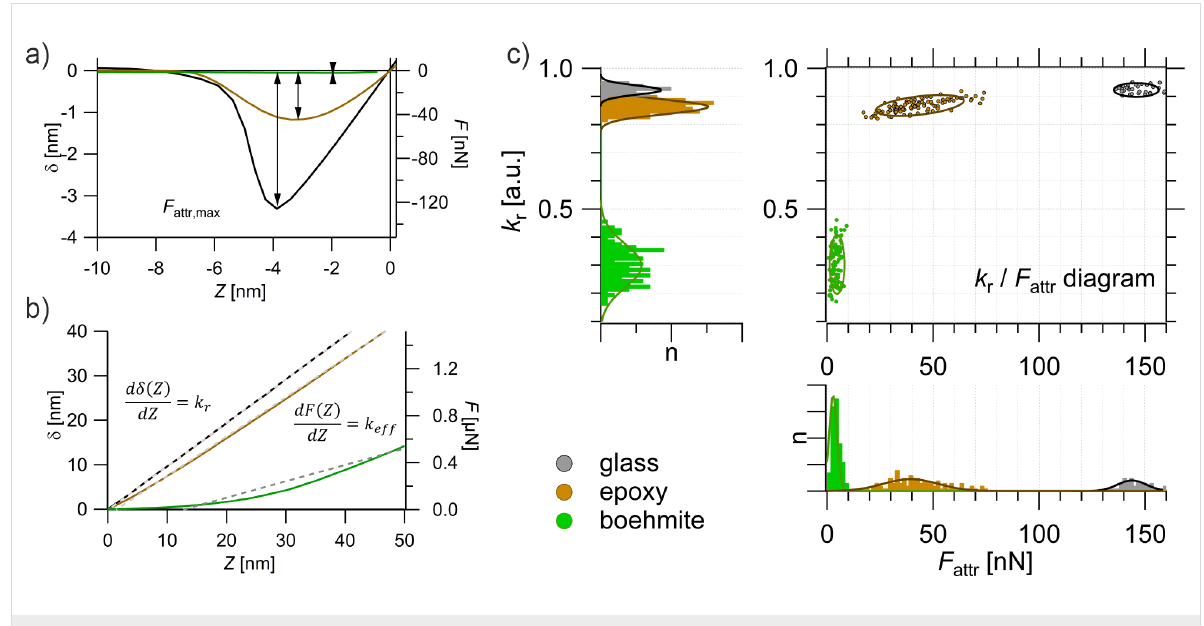
Figure 2: FDCs (averaged from at least 50 single curves) of bulk materials: boehmite (green), epoxy (brown), and glass (grey). (a) Regime of attrac- tive forces with F attr . (b) Regime of repulsive forces with k r and k eff . (c) Property domain: top left and bottom right are histograms of k r and F attr , re- spectively, of single FDC; top right: k eff / F attr diagram for the structure–property correlation. The measurements were performed with the tip